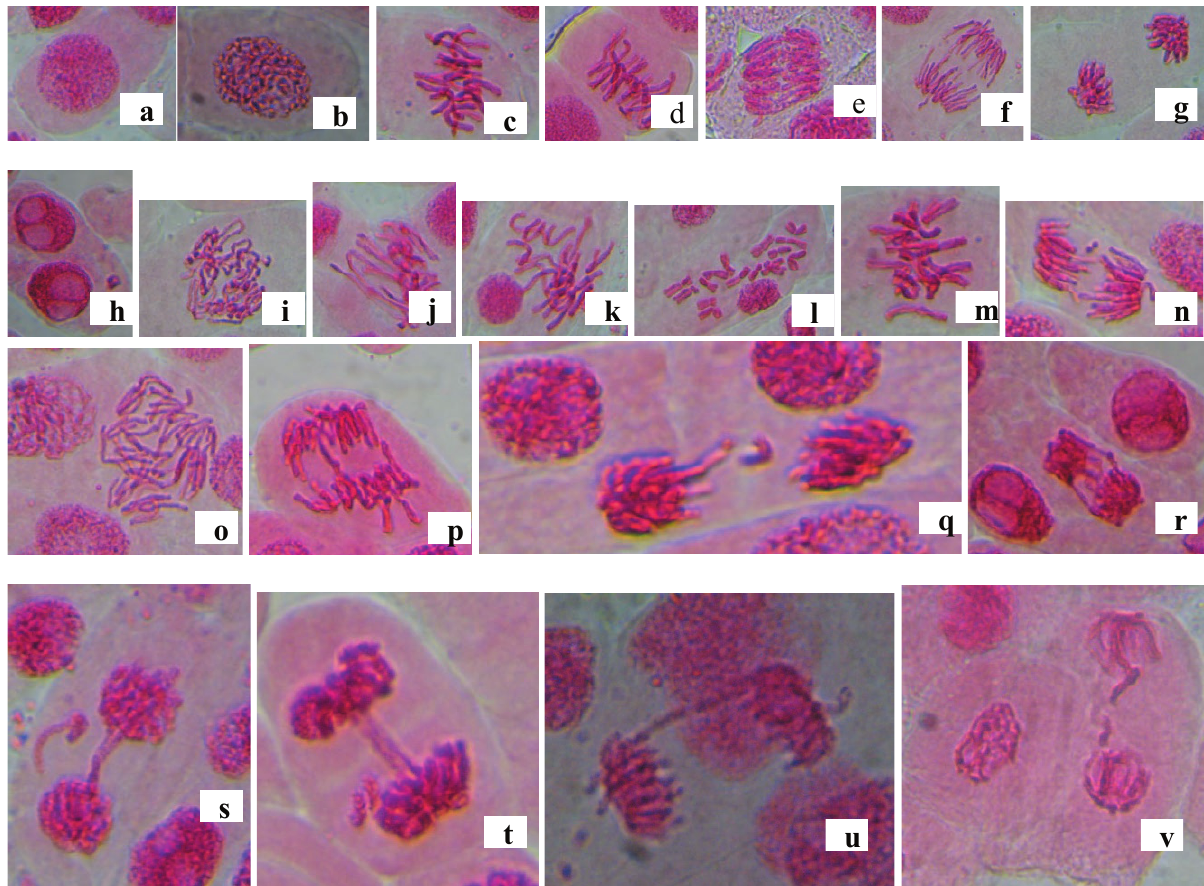
Figure 2. Photomicrographs of cells of Allium cepa showing untreated cells in normal division stages and Chromosomal aberrations (arrowed) in cells treated with methanol and ethyl acetate extracts of Cannabis sativa or mixture of extracts with EMS or Cyclophosphamide. (a) Interphase (b) Normal Prophase (c) Normal metaphase (d) Normal metaphase (e) Early anaphase (f) Late anaphase (g) Telophase (h) Pyknotic interphase nuclei with micronucleus (i) Prophase with sticky chromosomes (j) Metaphase with sticky chromosomes (k) Metaphase with sticky chromosomes (l) C-metaphase (m) Metaphase with dislocated chromosome (n) Late anaphase with dislocated chromosome (o) Anaphase with sticky and scattered chromosomes (p) Late anaphase with chromosome bridge (q) Telophase with lagging chromosome (r) Telophase with sticky chromosomes and bridge (s) telophase with chromosome bridge and lagging (t) telophase with chromosome bridge and fragment (u) Telophase with chromosome bridge (v) Telophase with chromosome fragment and lagging. Magnification is 1000